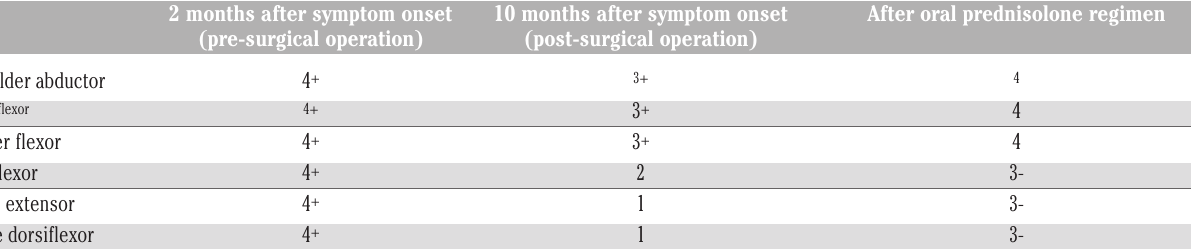
Table 1. Changes in MRC scores in the patient. (pre-surgical operation)